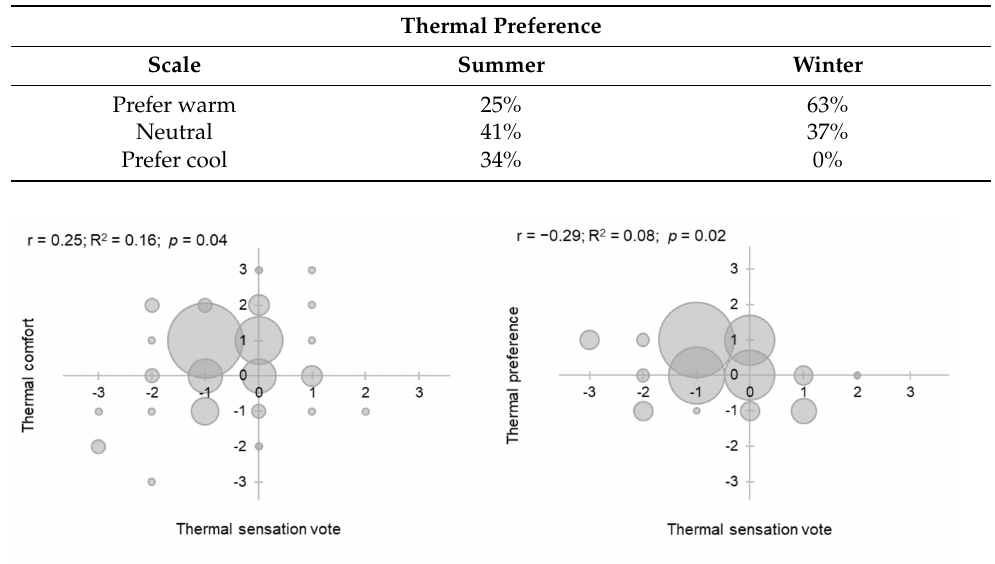
Table 6. Percentage of thermal preference and acceptance in summer and winter.